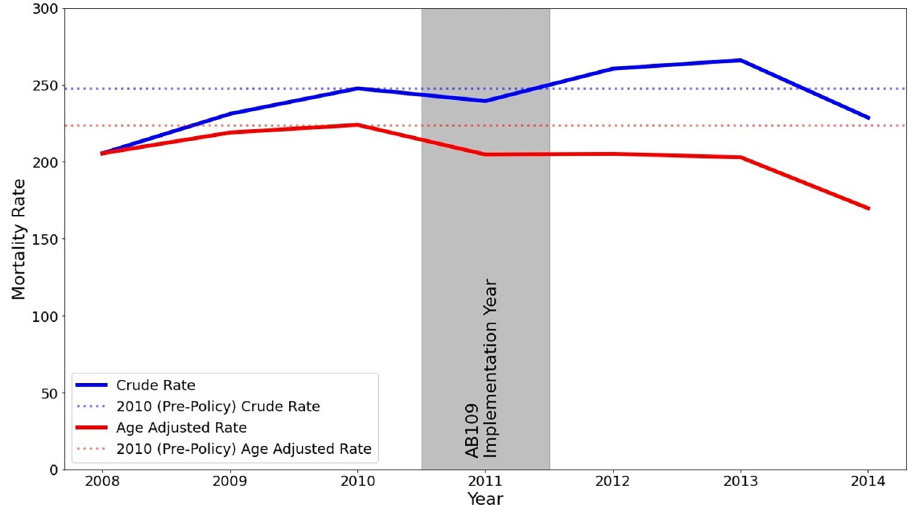
Fig 4. Crude and age-adjusted California prisoner mortality rates,